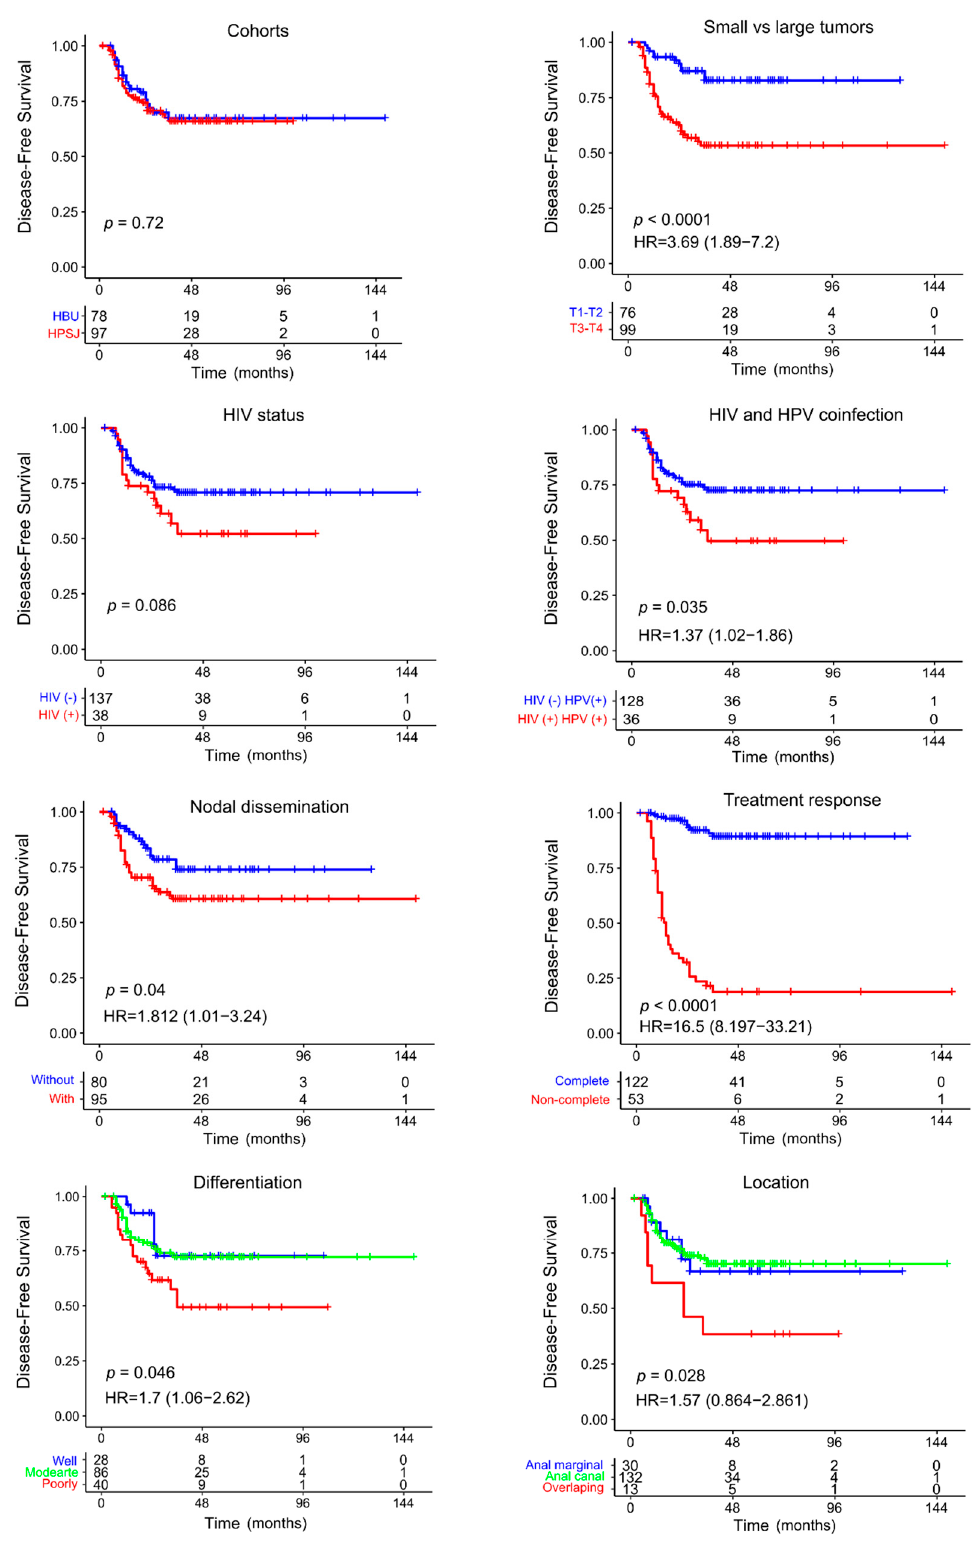
Figure 1. Kaplan–Meier DFS analysis and Cox regression analysis of NM-ASCC patients according to clinicopathological features.